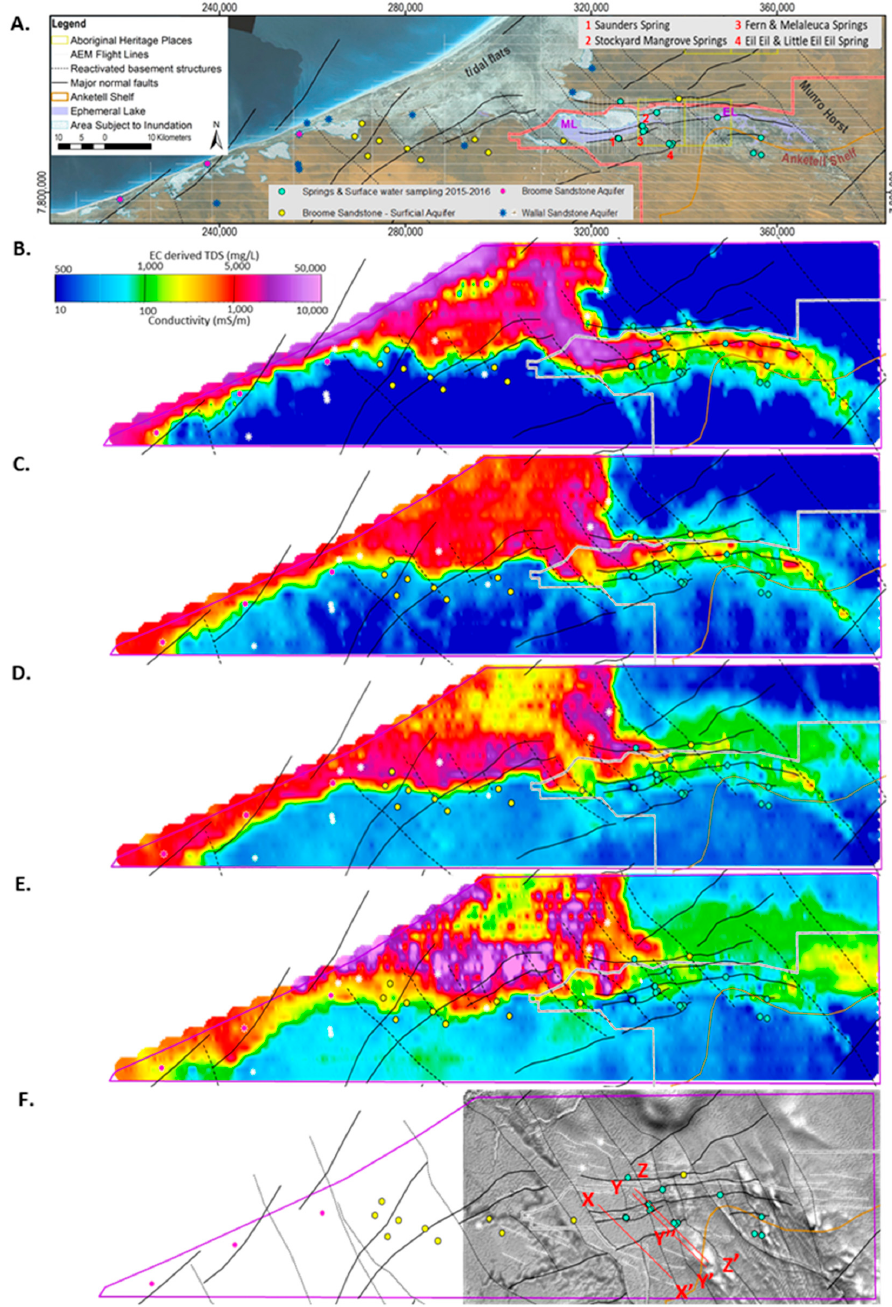
Figure 3. TEMPEST airborne electromagnetic (AEM) 1D layered earth inversion (LEI) (2016): ( A ). Study area superimposed on SPOT 5 Imagery (2009) showing AEM flight lines, the location of major geological and physiographic features including Mandora Lake (ML) and East Lake (EL) and the Walyarta Conservation Park boundary (in red) (Note: previous Park boundary fell within the 2016 AEM inversion area); pseudo-colored interval conductivity images (CDI) for the following: ( B ). 0–10 m below ground level (BGL); ( C ). 30–40 m BGL; ( D ). 60–70 m BGL; ( E ). 100–110 m BGL; ( F ). Airborne magnetic first vertical derivative (1VD) greyscale image displaying deeper north–northwest structures (black linework) and strandlines (white dashed linework); see subsequent figures for explanations on X-X’, Y-Y”-Y’ and Z-Z’. Note: see Section 2.2 for the AEM conductivity and groundwater quality (TDS; mg/L) relationship presented in the key.